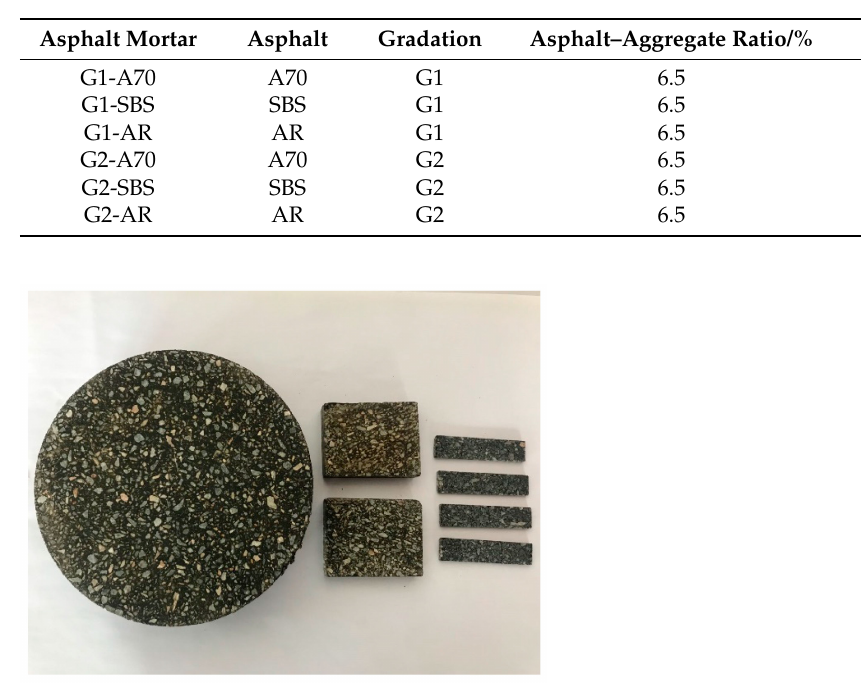
Table 3. Scheme of asphalt mortar molding.